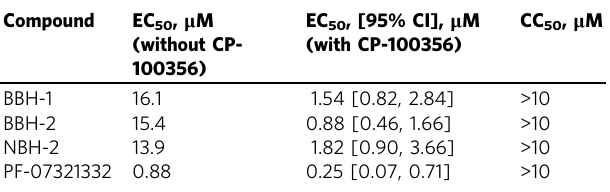
Table 2 In vitro antiviral parameters for SARS-CoV-2 M pro inhibitors measured in Vero E6 TMPRSS cells in the absence or presence of P-glycoprotein inhibitor